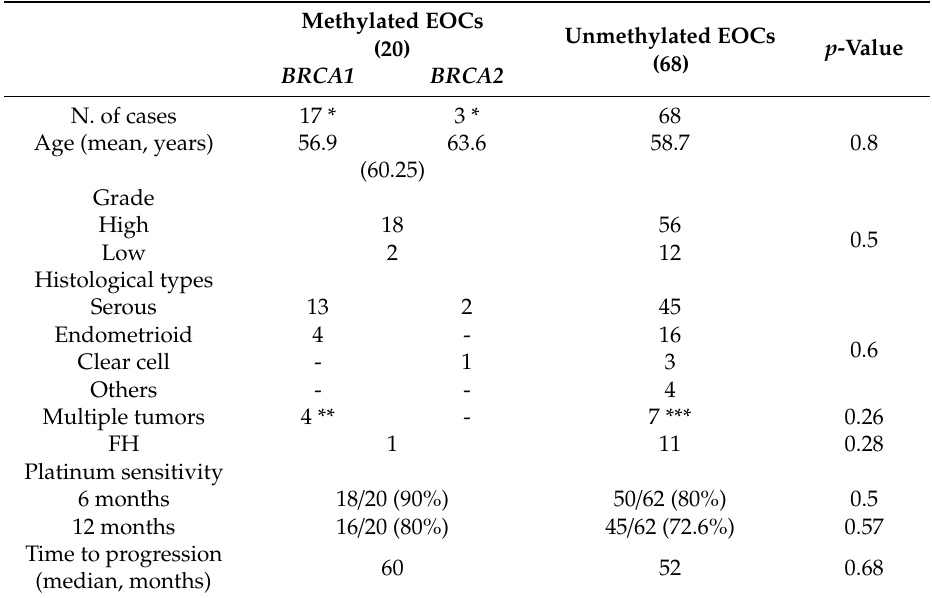
Table 1. Clinico-pathological data in relationship to methylation status of ovarian cancers.